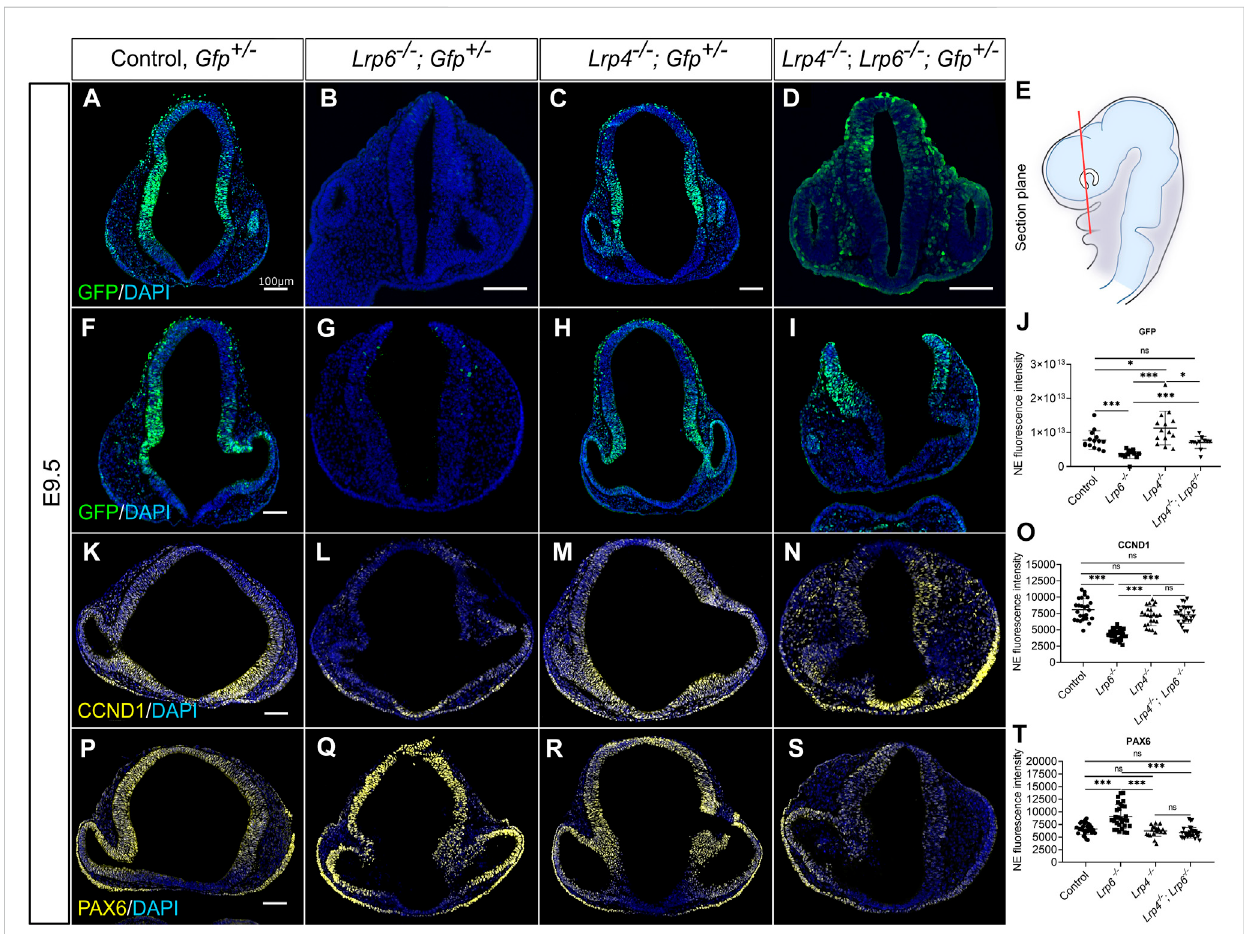
FIGURE 6 Genetic inactivation of LRP4 rescues impaired canonical WNT activity and downstream target gene expression in Lrp6 − / − mutants. (A – J) TCF/Lef: H2B-GFP transgenic mouse line was used to visualize and quantify WNT/ß-catenin-signalling in neuroepithelial cells of all Lrp genotypes and controls. Quanti fi cation of GFP immunohistochemistry signals were performed on coronal forebrain sections from E9.5 mouse embryos. (E) Section plane for representative images is indicated in the schematic. (A – D) Representative images show forebrain sections from E9.5 embryos with closed cranial neuraltubeforallgenotypes. (F – I) ImagesshowforebrainsectionsfromE9.5embryoswithopencranialneuraltubephenotypefor Lrp6 − / − ; Gfp + mutants and Lrp4 − / − ; Lrp6 − / − ; Gfp + doublemutants.Wild-type; Gfp + controlsand Lrp4 − / − ; Gfp + embryosnevershowedneuraltubedefects.Immunohistochemistry images in (A, F) show thepattern and intensity of GFP signals in wild-type controls, which displayedWNT/ß-catenin activity in the dorsolateral domain of theforebrainneuroepithelium.Inage-matchedandplane-matchedforebrainsectionsof Lrp4 − / − ; Gfp + embryos (C,H) ,asimilarpatternandintensityasin wild-type; Gfp + controls were observed. In the neuroepithelium of Lrp6 − / − ; Gfp + forebrains (B, G) signi fi cantly less GFP signal intensity was detected compared to controls, indicating a decrease in canonical WNT signalling activity. Lrp4 − / − ; Lrp6 − / − ; Gfp + double mutants (D, I) showed GFP intensity levels that were signi fi cantly higher than in Lrp6 − / − ; Gfp + single mutants and similar to wild-type; Gfp + controls, suggesting a clear rescue of canonical WNT signalling activityupondepletion ofLRP4functionin Lrp6 − / − mutants.ThereducedWNT/ß-cateninactivityin Lrp6 − / − ; Gfp + singlemutantsandtherescue ofcanonicalWNT/ß-cateninactivityinLRP6-de fi cientforebrainsbygeneticablationofLRP4wasalsoobservedregardlessofwhethertheembryoshada closed neural tube (B, D) or displayed cranial NTDs (G, I) . (J) Graph shows quanti fi cation of mean GFP signal fl uorescence intensity, y axis: fl uorescence intensityintheentireneuroepithelium(NE).Atotalof4-6coronalsectionsfromeachembryowereexaminedfromE9.5wild-type; Gfp + embryos( n =3), Lrp6 − / − ; Gfp + mutants ( n = 3), Lrp4 − / − ; Gfp + mutants ( n = 3) and Lrp4 − / − ; Lrp6 − / − ; Gfp + double mutants ( n = 3). Scatter plot presents mean ± s.d.; the signi fi cance was assessed with student t-test; p values: * p < 0.05, *** p < 0.001. NE: neuroepithelium. (K – N) Cyclin D1 (CCND1) is a known WNT/ß- catenin downstream target gene and a cell cycle regulator. Images show immunohistochemistry for Cyclin D1 on coronal forebrain sections. Lrp4 − / − ; Lrp6 − / − double mutants exhibited signi fi cantly stronger signals for Cyclin D1 in the neuroepithelium compared to Lrp6 − / − single mutants, which had dramatically reduced Cyclin D1 levels compared to controls. Lrp4 − / − single mutants displayed similar levels of Cyclin D1 as wild-type controls. (O) Graph shows quanti fi cation of Cyclin D1 immunohistochemistry signal intensity, y axis: mean fl uorescence intensity in the entire neuroepithelium. Immuno fl uorescence intensity of Cyclin D1 measured in the neuroepithelium from E9.5 wild-type; Gfp + embryos ( n = 3), Lrp6 − / − ; Gfp + mutants ( n = 4), Lrp4 − / − ; Gfp + mutants( n =3)and Lrp4 − / − ; Lrp6 − / − ; Gfp + doublemutants( n =3).Atotalof7 – 12coronalsectionsfromeachembryowereexamined.Scatter plot presents mean ± s.d.; the signi fi cance was assessed with one-way ANOVA; p value: *** p < 0.001. (P – S) PAX6 is another downstream target of the WNT/ß-catenin pathway but in contrast to Cyclin D1 negatively regulated. Accordingly, Lrp6 − / − embryos showed stronger signals for PAX6 compared to wild types and compared to Lrp4 − / − mutants, which showed a normal pattern for PAX6 in the mediolateral anterior neural tube. Lrp4 − / − ; Lrp6 − / − mutants showed PAX6 signal intensity and PAX6 patterncomparableto wild-typecontrols and therefore arescue of impaired PAX6 proteinlevels inLrp6 − / − single mutants. (T) Graph shows quanti fi cation of PAX6 immunohistochemistry signal intensity, y axis: mean fl uorescence intensity in the entire neuroepithelium. Immuno fl uorescence intensity of GFP measured in the neuroepithelium from E9.5 wild-type; Gfp + embryos (n = 3), Lrp6 − / − ; Gfp + mutants ( n = 4), Lrp4 − / − ; Gfp + mutants ( n = 3) and Lrp4 − / − ; Lrp6 − / − ; Gfp + double mutants ( n = 3). A total of – 15 coronal sections from each embryo were examined. Scatter plot presents mean ± s.d.; the signi fi cance was assessed with one-way ANOVA; p value: *** p < 0.001. Scale bars: 100